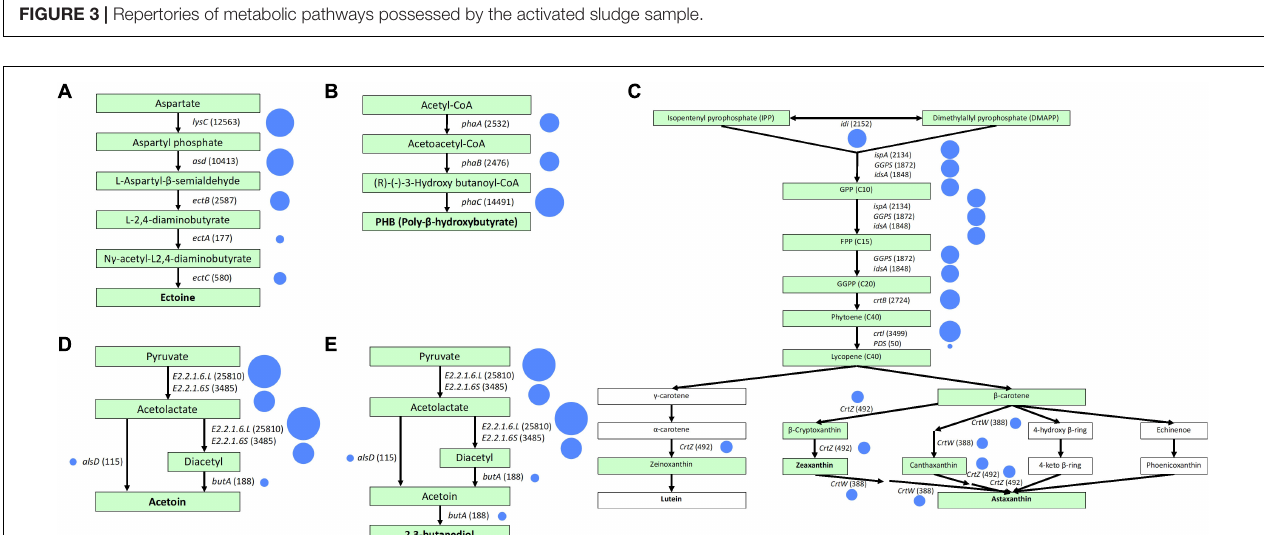
FIGURE 3 | Repertories of metabolic pathways possessed by the activated sludge sample.